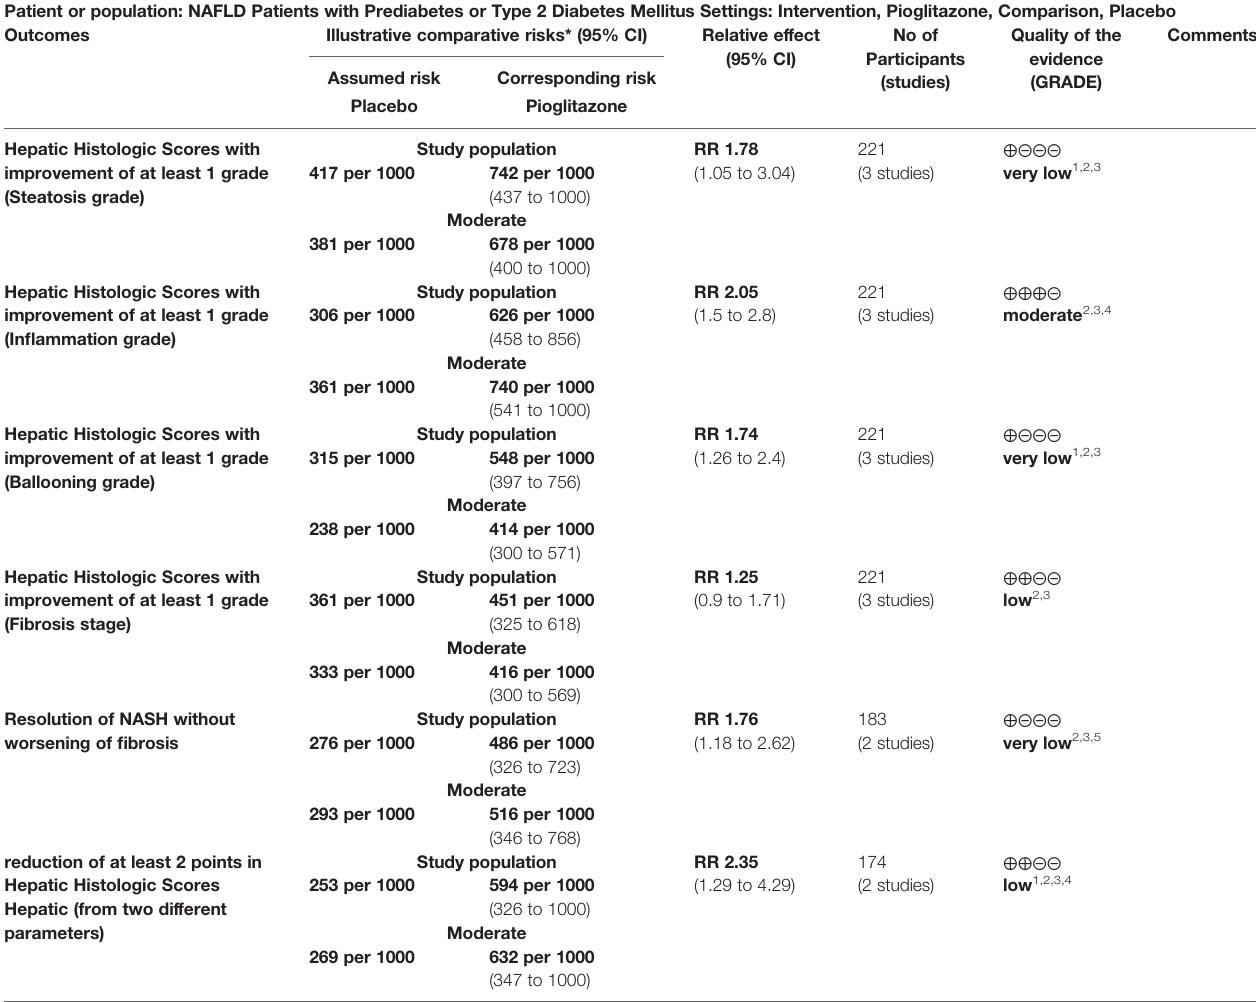
TABLE 1 | Pioglitazone compared to Placebo for NAFLD Patients with Prediabetes or Type 2 Diabetes Mellitus. Patient or population: NAFLD Patients with Prediabetes or Type 2 Diabetes Mellitus Settings: Intervention, Pioglitazone, Comparison, Placebo